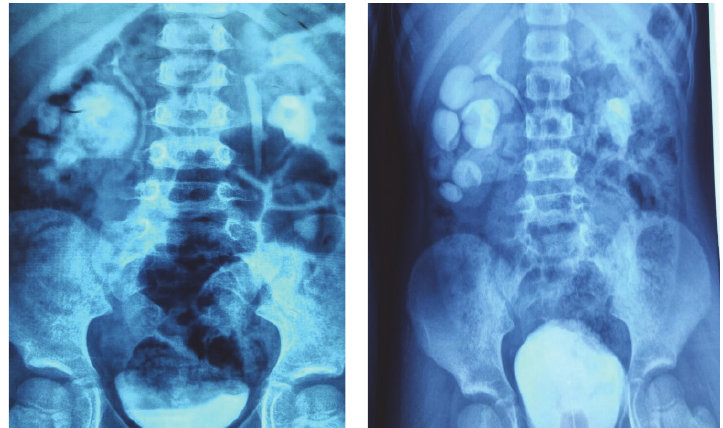
Figure 2: Intravenous examination showing the duplex system on the right side with the UPJO of the lower moiety.